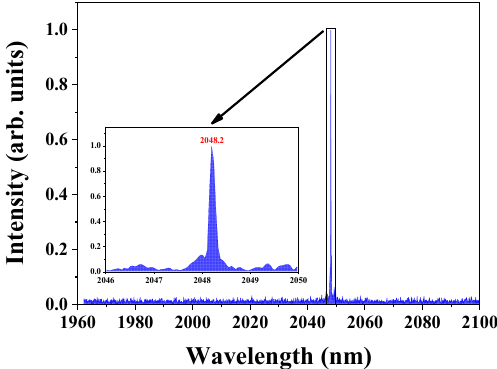
Figure 5. Power characteristics of the Tm:YAG ‐ Ho:GdVO 4 laser. The spectrum of the Tm:YAG ‐ Ho:GdVO 4 laser at the maximum output level is shown in Figure 6. The central wavelength was 2048.2 nm with a 0.2 nm linewidth. When the pump power was near the threshold, the laser wavelength of Tm:YAG was also observed. The theoretical slope efficiency was calculated to be 98.3% for the pump of Tm:YAG and the laser of Ho:GdVO 4 . Under a Tm ‐ wavelength of 2014.1 nm and Ho ‐ wavelength of 2048.2 nm, the limited slope efficiency was estimated to be 98.3%. However, this slope pump absorption efficiency of Ho crystal. The single ‐ pass pump absorption of the Ho:GdVO 4 crystal was calculated to be 29.8% in this experiment. To increase the slope efficiency, stronger pump absorption was required. However, excessive pump absorption is not acceptable because Tm laser radiation needs to operate at a high power level. for increasing the slope efficiency.